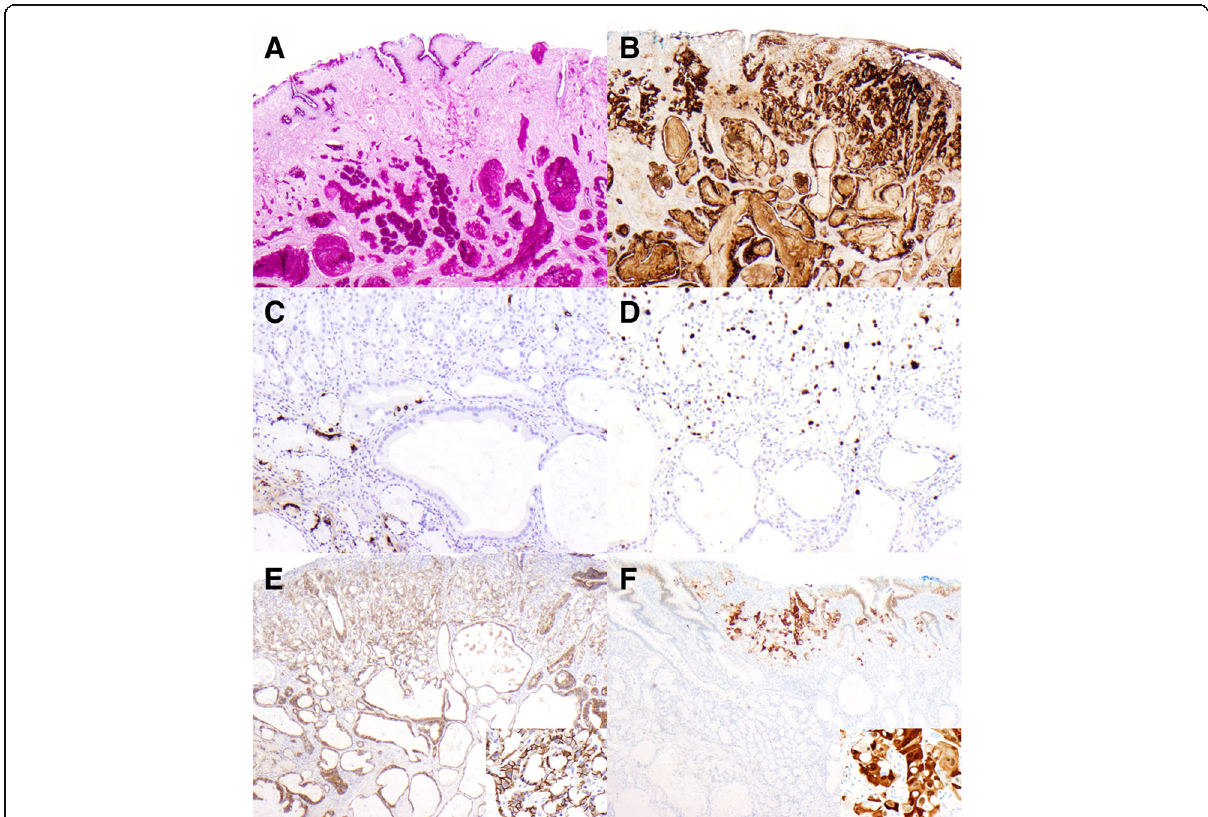
Fig. 3 Special and immunohistochemical stains. a Periodic acid – Schiff with diastase digestion (4x): diffusely and strongly positive in tumor cells and secretion. b Lysozyme (4x): diffusely and strongly positive in tumor cells and secretion. c Chromogranin (10x): highlighted residual normal neuroendocrine cells. d Ki67 (10x): approximately 40% tumor cells in the poorly-differentiated area (upper half) were positive and only rare positivity was detected in the well-differentiated area (lower half). e beta- catenin (4x) (inset: high magnification (40x) of beta-catenin): membranous stain in all the tumor cells regardless of differentiation. f Her-2/neu (4x) (inset: high magnification (40x) of Her-2/neu in the poorly- differentiated area): nuclear and cytoplasmic stain in the poorly-differentiated area and absence of stain in the well-differentiated